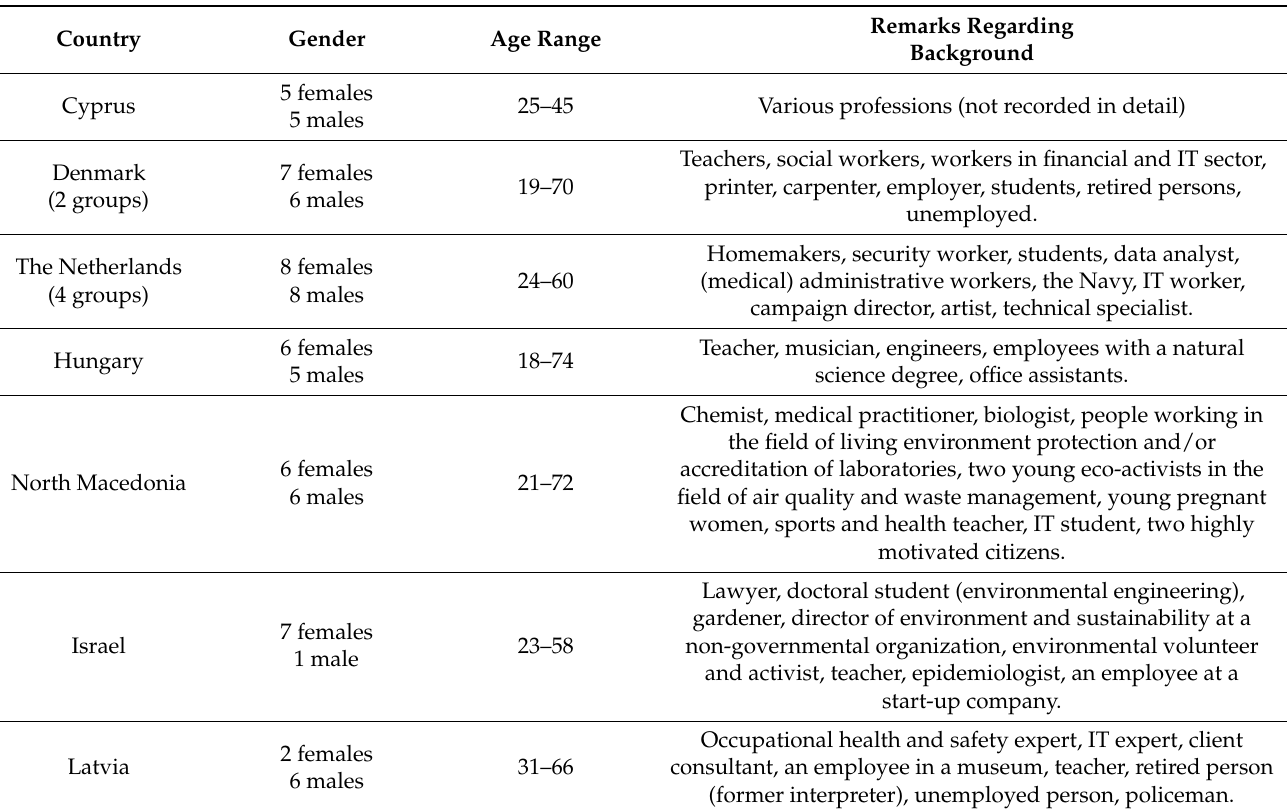
Table 2. Sample characteristics by